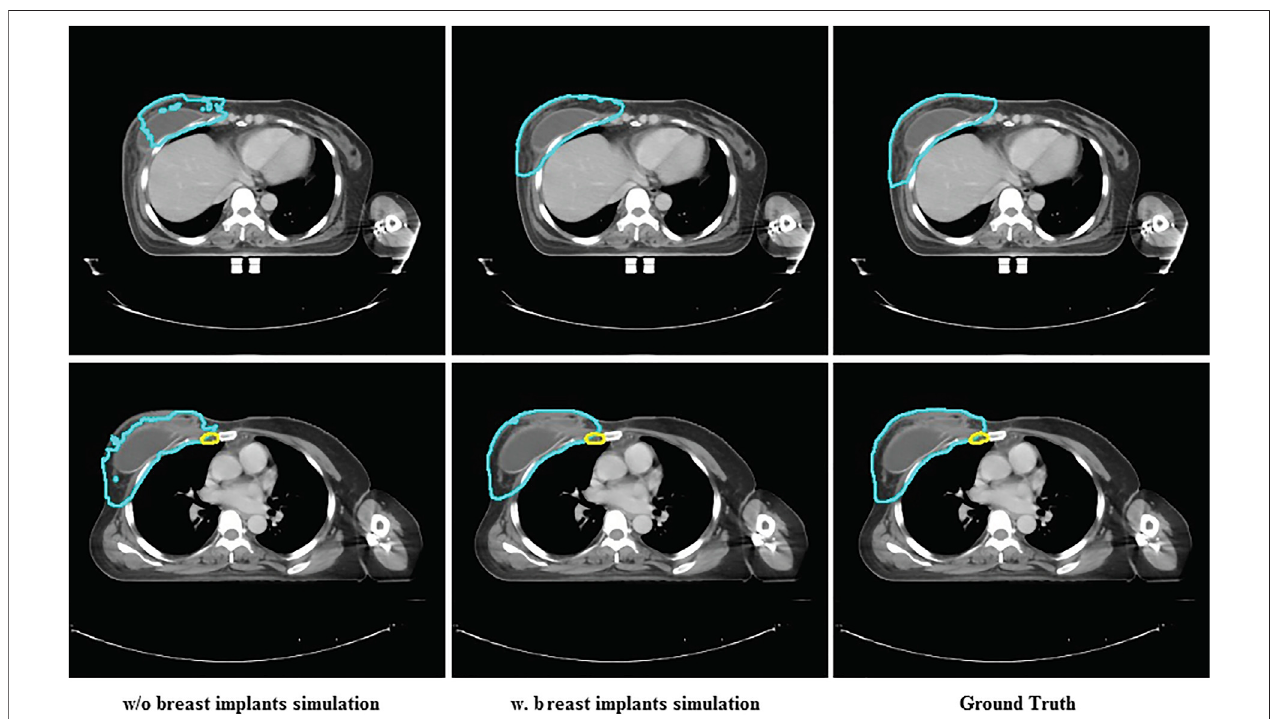
FIGURE 7 | The comparison between the segmentation results of U-Net and the proposed method and ground truth on the case with breast implants.